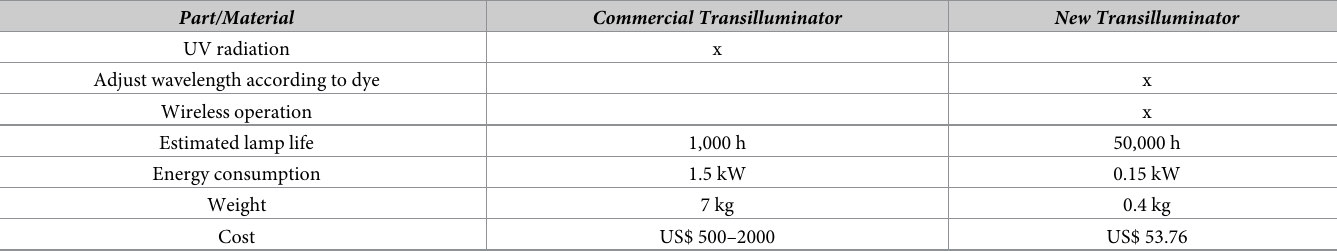
Table 4. Features and specifications comparison between a conventional commercial transilluminator and the proposed device.